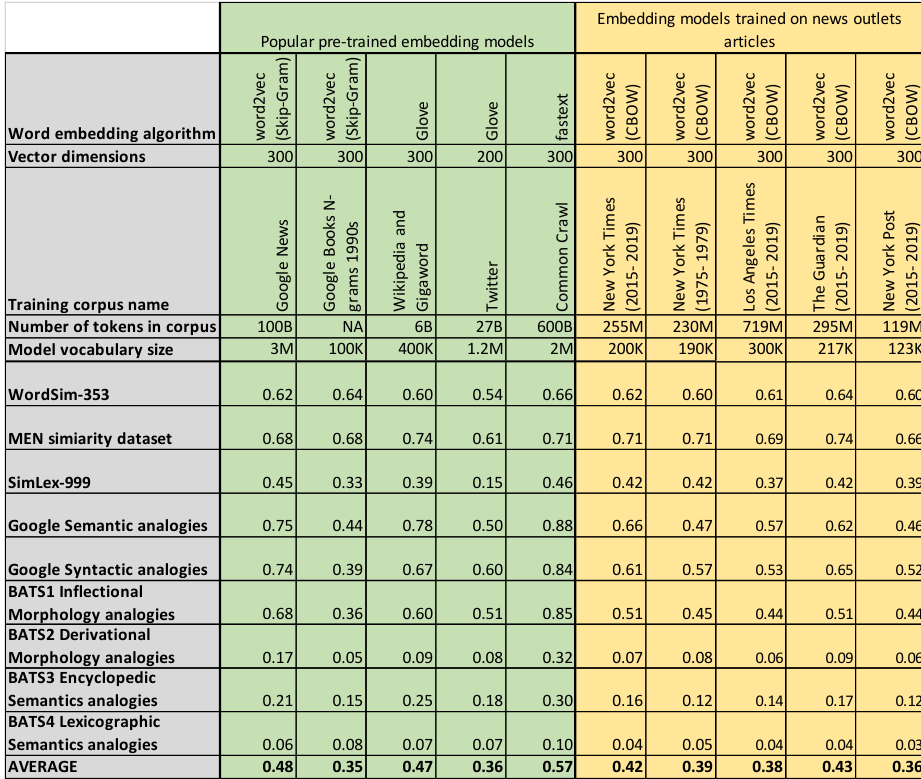
Table 1. Performance comparison between popular pre-trained embedding models (green) and word embedding models trained on outlet-specific news articles text (yellow) across commonly used validation metrics for embedding